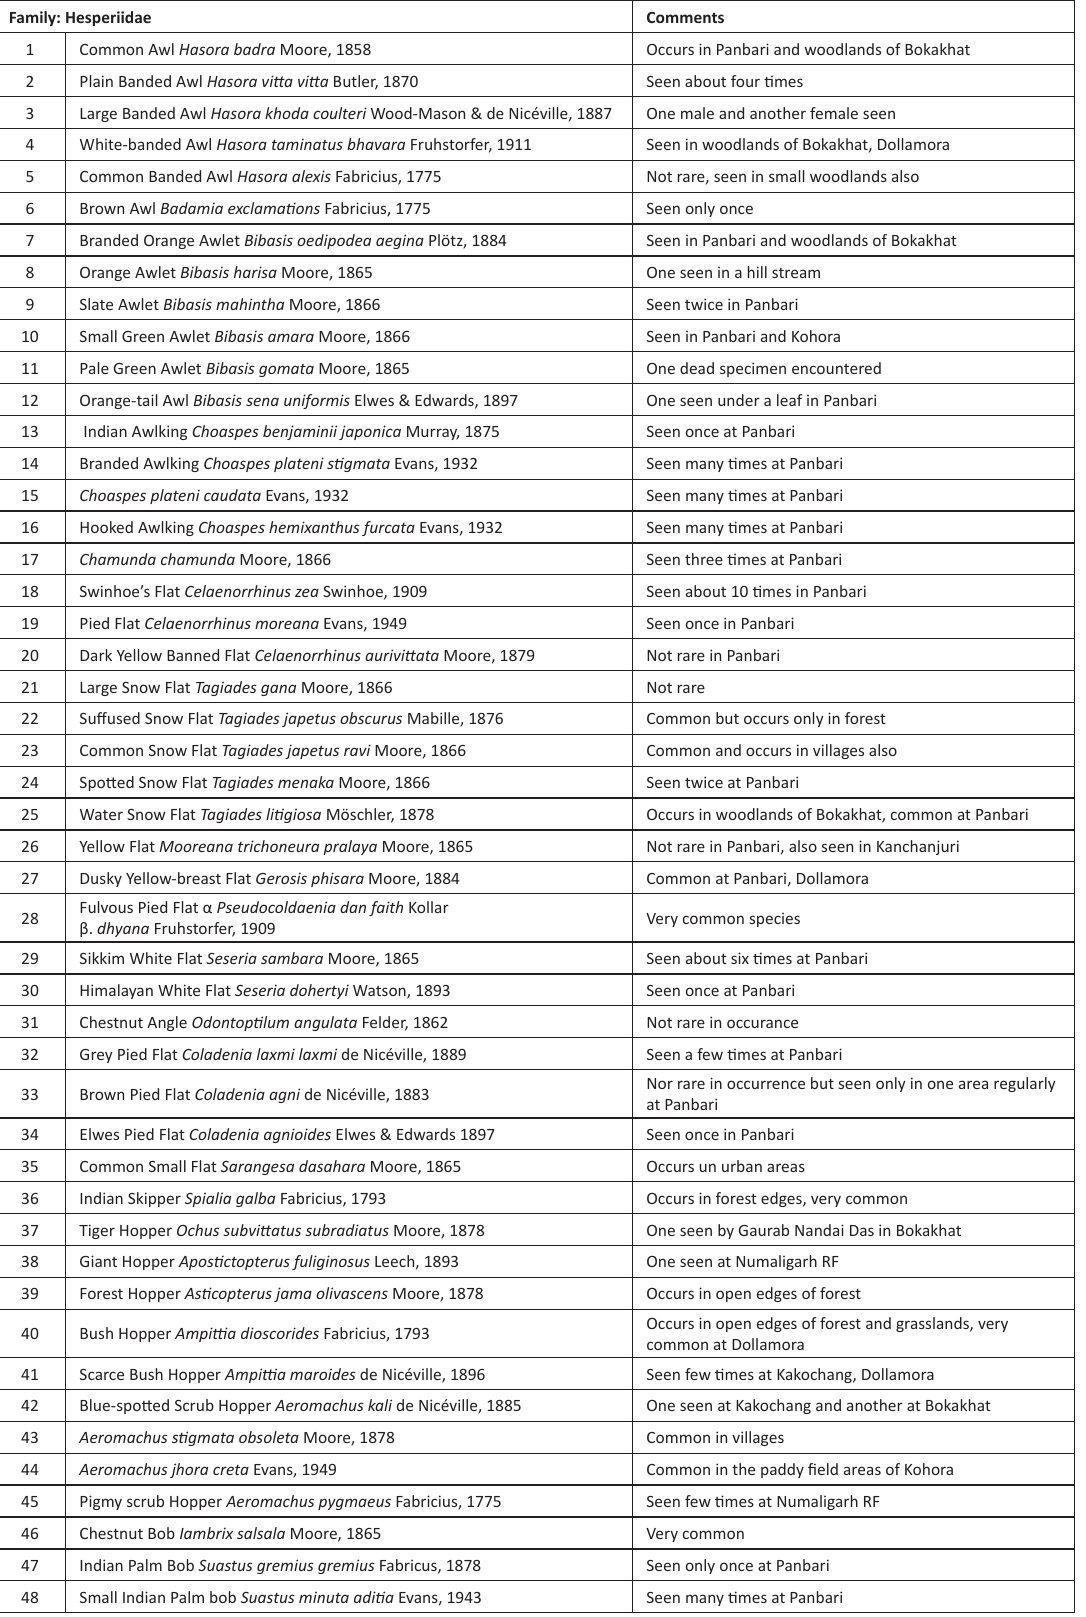
Table 1. A preliminary checklist of skippers recorded in Panbari Forest of Kaziranga and neighbouring areas of Karbi Hills (2008–2012) Family: